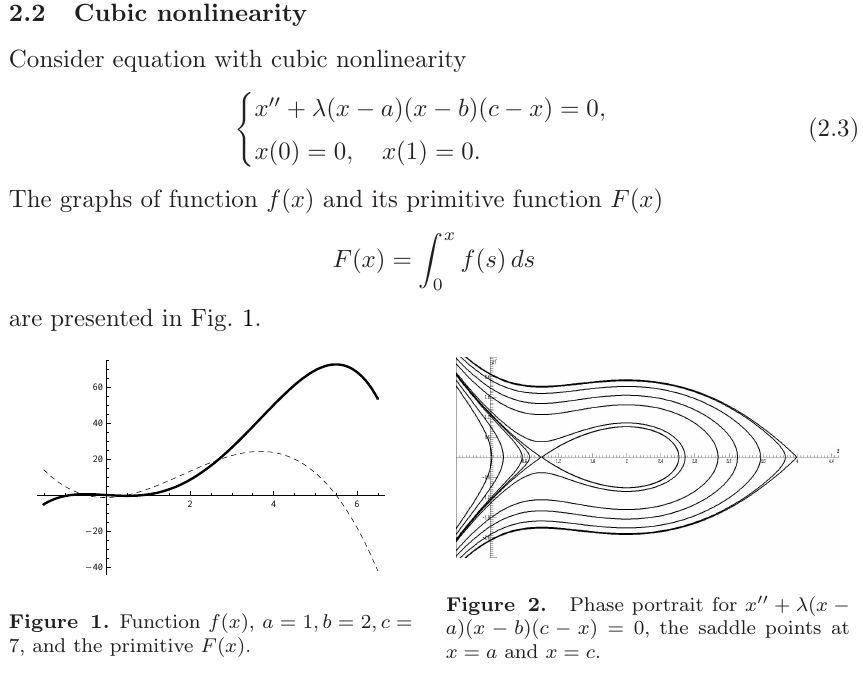
Figure 2. Phase portrait for x ′′ + λ ( x − a )( x − b )( c − x ) = 0 , the saddle points at x = a and x =